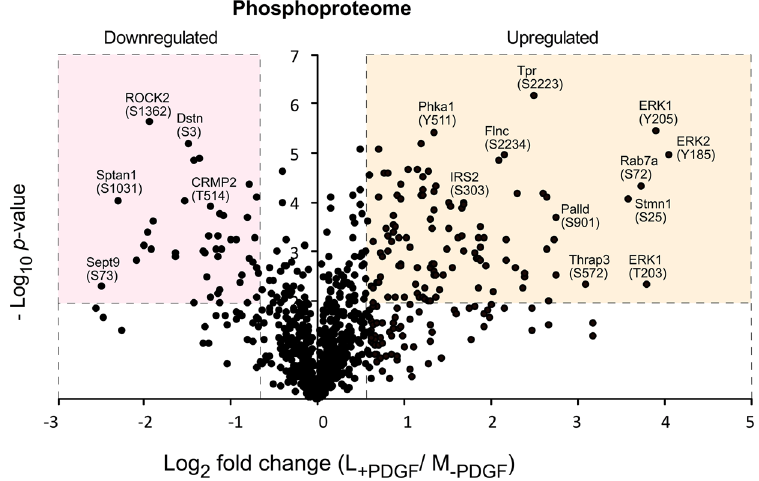
Figure 2. Volcano plots showing the magnitude and significance of differential phosphopeptide abundance in PDGF-stimulated versus unstimulated cells. Phosphopeptides are deemed significantly up- or down-regulated if they have an adjusted p value < 0.05 and exhibit a > 1.5 fold-change in